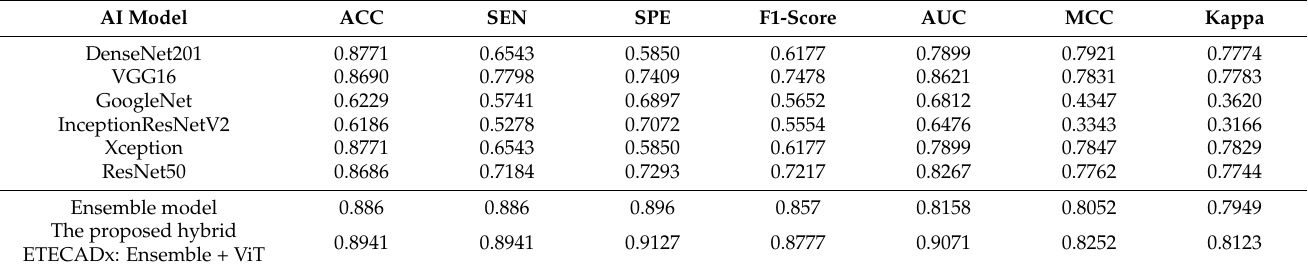
Table 11. Validation classification results for the multi-classification approach using all AI models including the ensemble learning and the proposed ETECADx framework. The real unseen dataset (Dataset2-B) is used for this